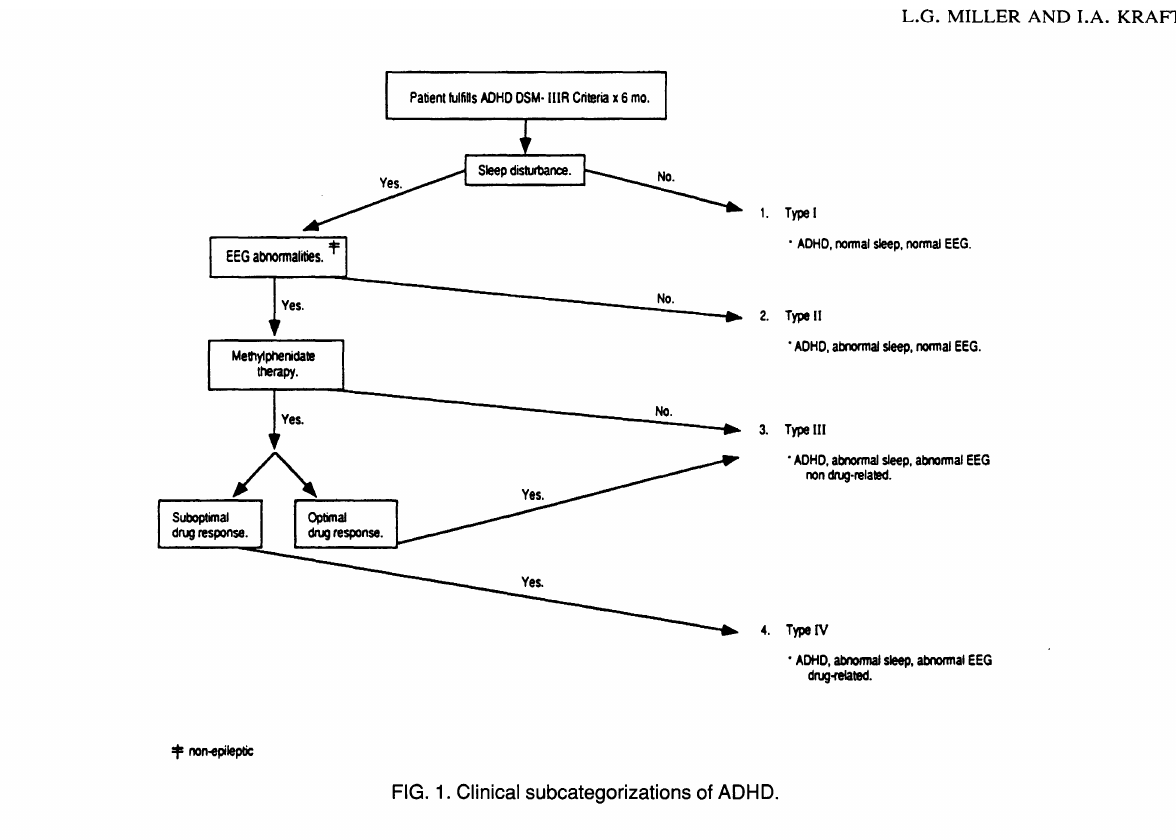
FIG. 1. Clinical subcategorizations of